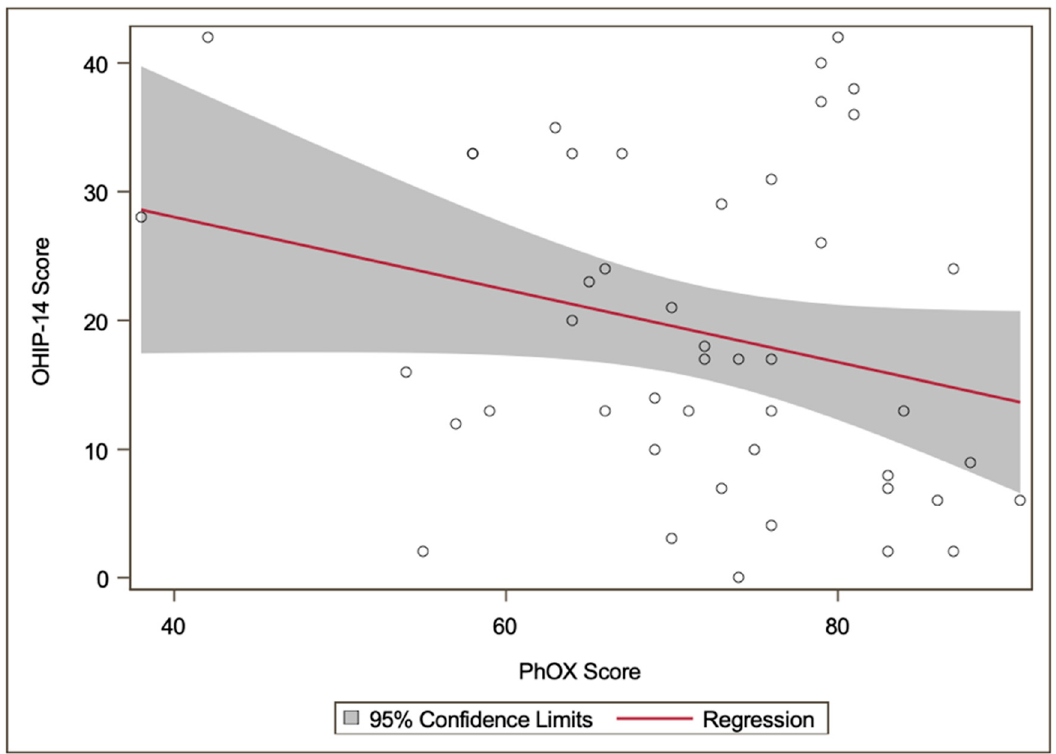
Figure 2. Scatterplot of OHIP-14 and PhOX scores with linear regression (Spearman correlation coefficient r = − 0.24) and 95% confidence limits of the regression coefficient.